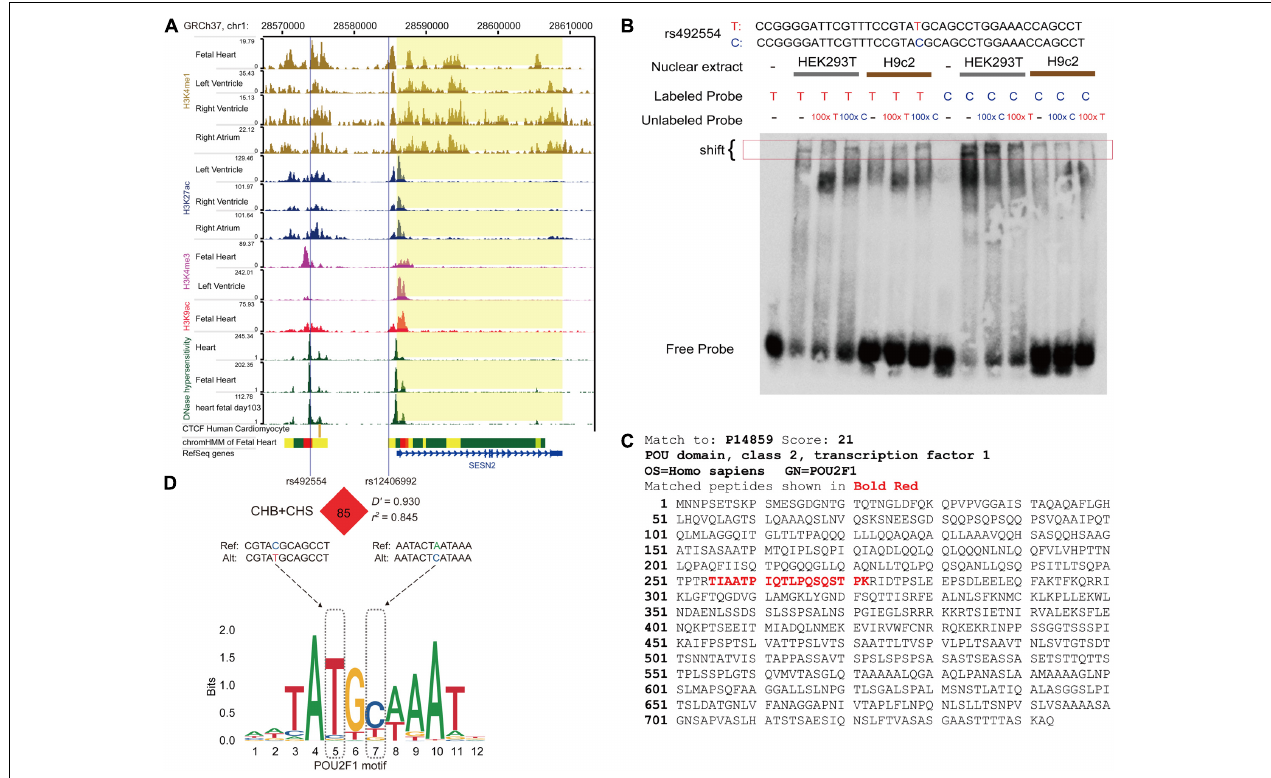
FIGURE 2 | The protective allele T of rs492554 enhances the potential binding affinity of transcription factor POU2F1. (A) Genome browser tracks for functional annotation of the upstream and downstream flanking sequences of SESN2 in heart or fetal heart tissues. (B) EMSAs were performed using biotin-labeled double-stranded oligonucleotides for the T and C alleles of rs492554 and nuclear extracts from HEK293T cells and H9c2 cells. 100 × molar excess of unlabeled competitor was added in specified lanes. The rs492554 protective T allele drives preferential protein binding. Red 100 × refers to the T allele-containing probe. Blue 100 × refers to the C allele-containing probe. (C) Peptide of POU2F1 protein identified by mass spectrometry from the shifted protein bands of EMSAs. (D) rs12406992 is located in the putative promoter region of SESN2 and is in strong linkage disequilibrium with rs492554 in the Han population (CHB and CHS). rs492554 and rs12406992 reside within POU2F1 DNA-binding motifs.